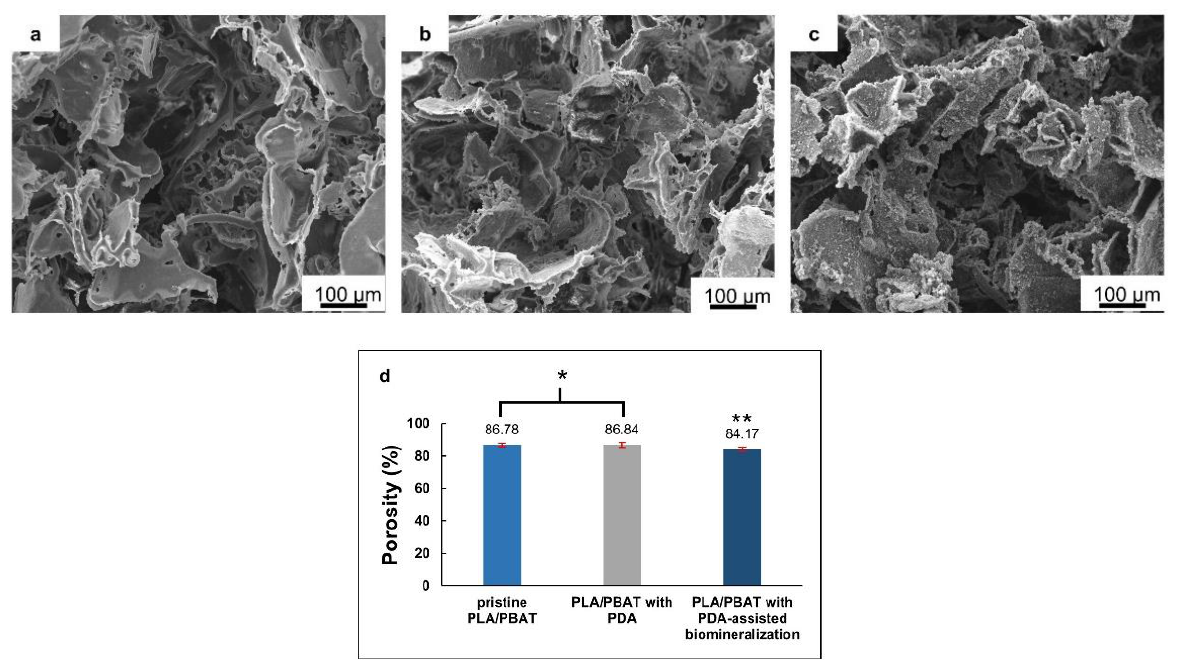
Figure 4. The scanning electron microscope (SEM) images of the pristine PLA/PBAT scaffolds ( a ), the PLA/PBAT scaffold with PDA surface modification ( b ), and the PLA/PBAT scaffold with PDA- assisted biomineralization ( c ). The percentage of porosity of the scaffold measured by the gravimetric method ( d ). The difference in number of asterisks represents statistical significance ( p ≤ 0.05).